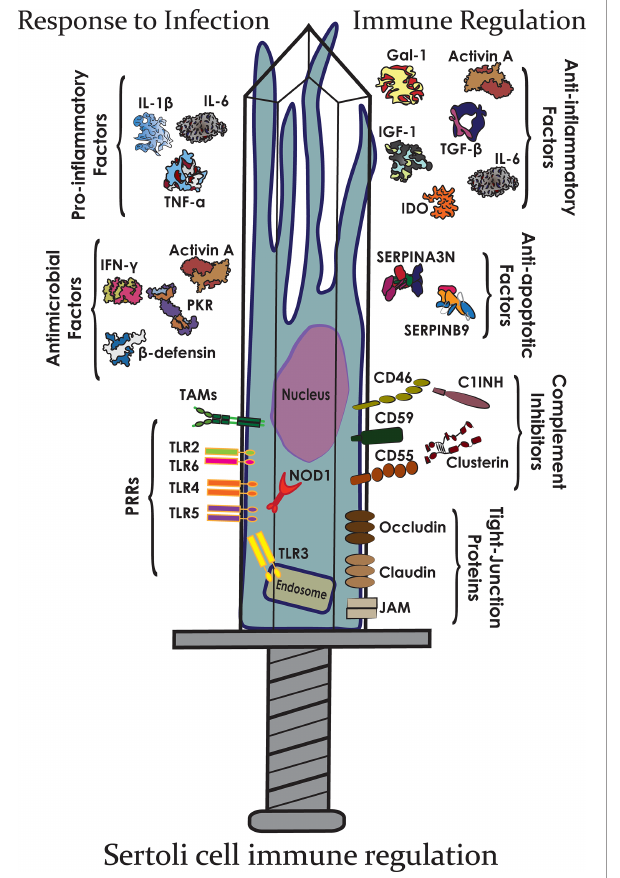
FIGURE 2 | The Sertoli cell double-edged sword. Sertoli cells express many different immunomodulatory factors that allow them to protect germ cells from both infection and immune